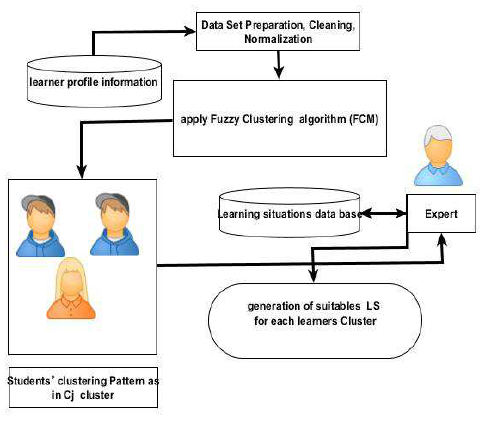
Figure 1. Overview of our approach.